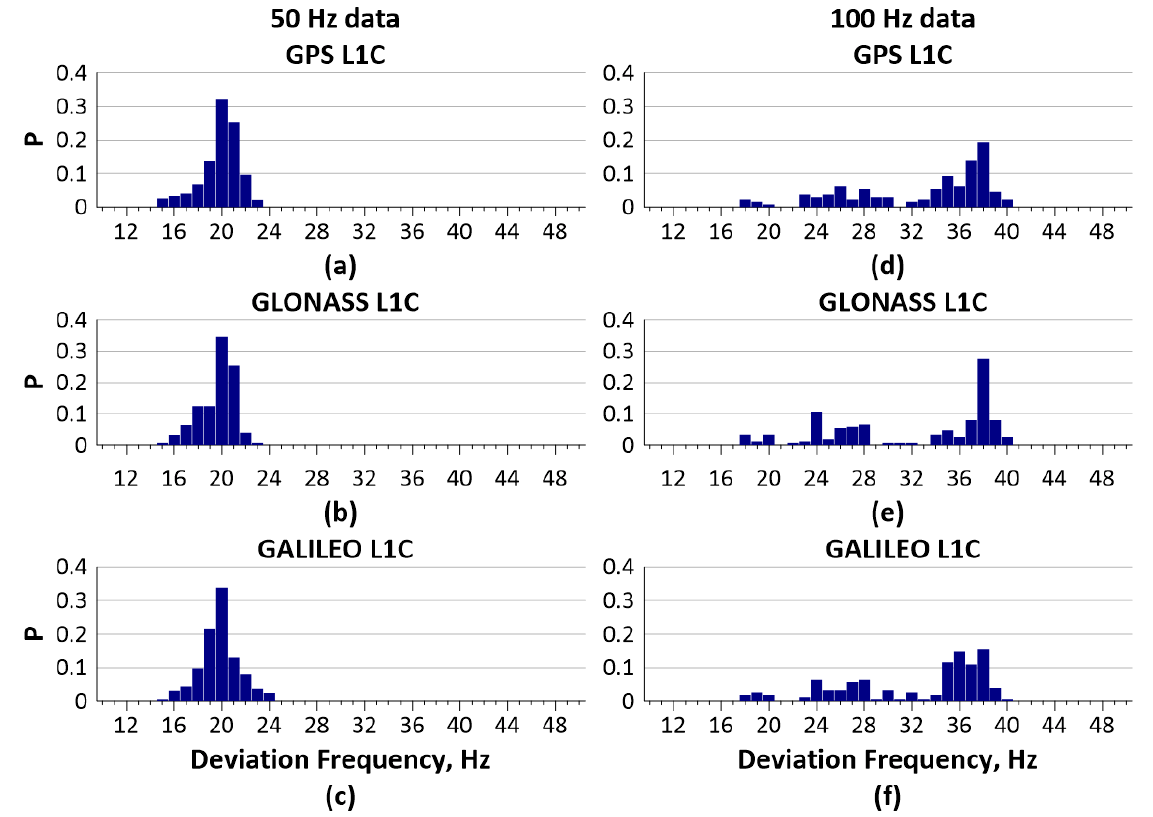
Figure 3. The fd distributions on 2 September 2022 for L1C signals of 50 Hz (left panels) and 100 Hz data (right panels), GPS ( a , d ), GLONASS ( b , e ) and Galileo ( c , f ). P is the normalized probability of the fd